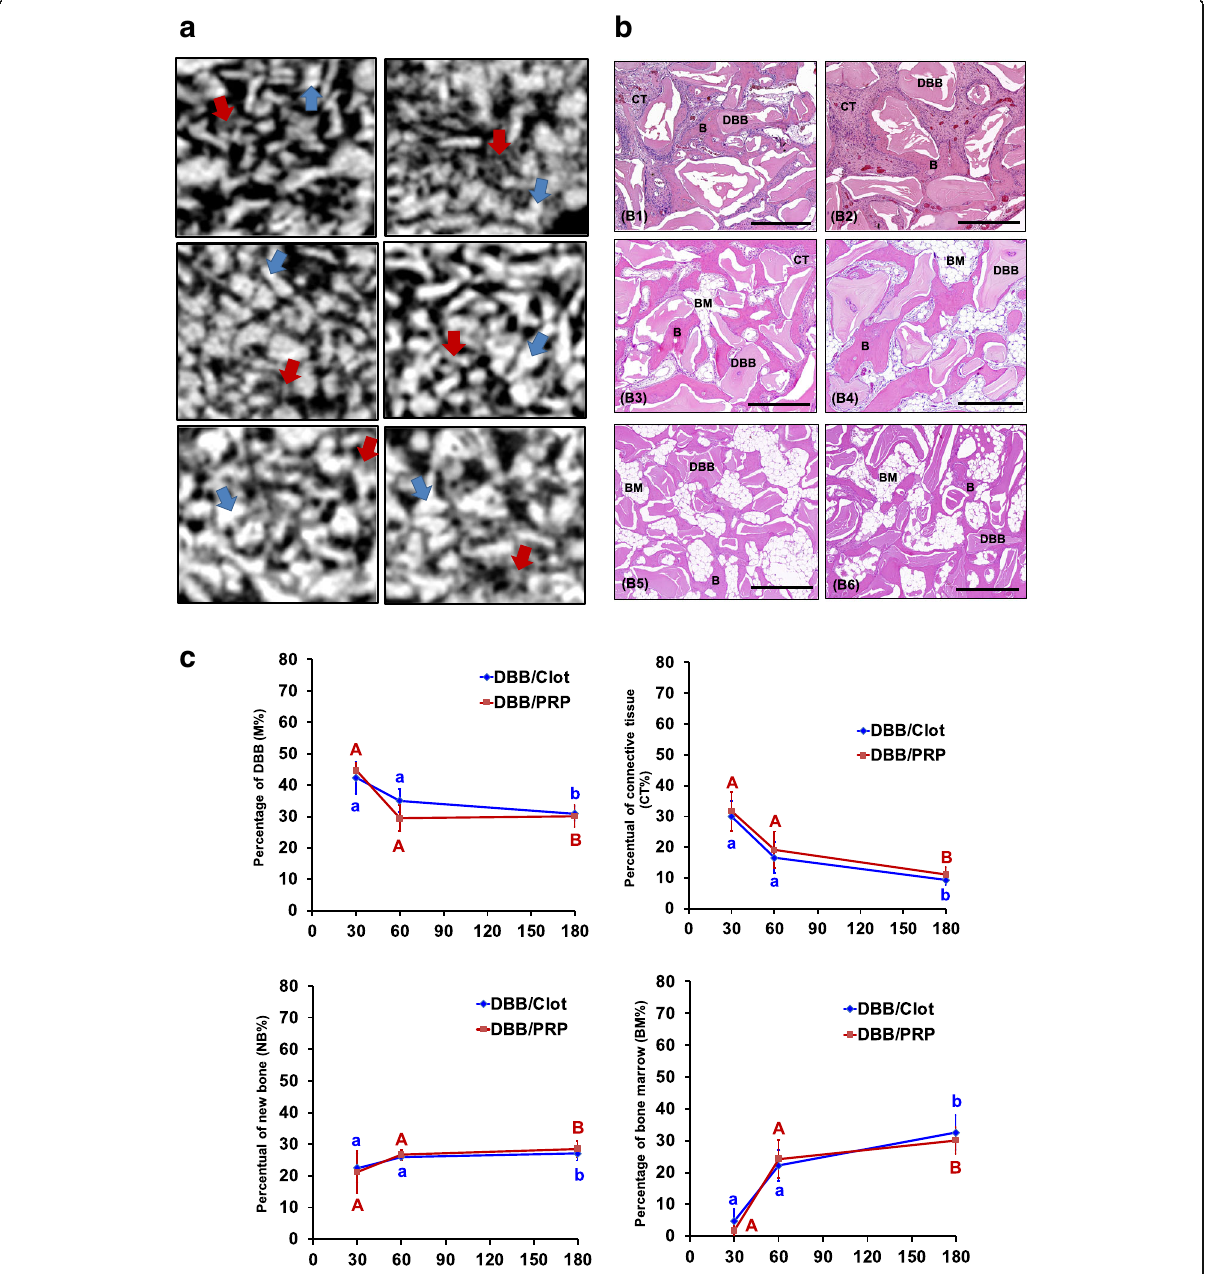
Fig. 4 Micro-CT and histomorphometric results for DBB group. a 2D-Micro-CT view: the images show small and irregular DBB particles (blue arrow) surrounded by new bone (yellow arrow) at 30 days. Between 30 and 180 days, the spaces were filled by bone. b Histologic view: at 30 days note that the bone formation occurred on the surface of the DBB (area surrounded by black dotted line), the spaces were filled by connective tissue (CT) rich in cells and blood vessels. At 60 days, the spaces between the particles were occupied by a large amount of bone (yellow arrow) and bone marrow (BM) replacing connective tissue. At 180 days, lamellar bone tissue and some areas of osteoclastic reabsorption in both biomaterial and bone. HE; 10×, c ) Percentage of each constituent: graphs of evolution of M% ( C1 ), CT% ( C2 ), NB% ( C3 ), and BM% ( C4 ) in MSA of DBB/clot and DBB/PRP. Different letters p < 0.05 among periods per